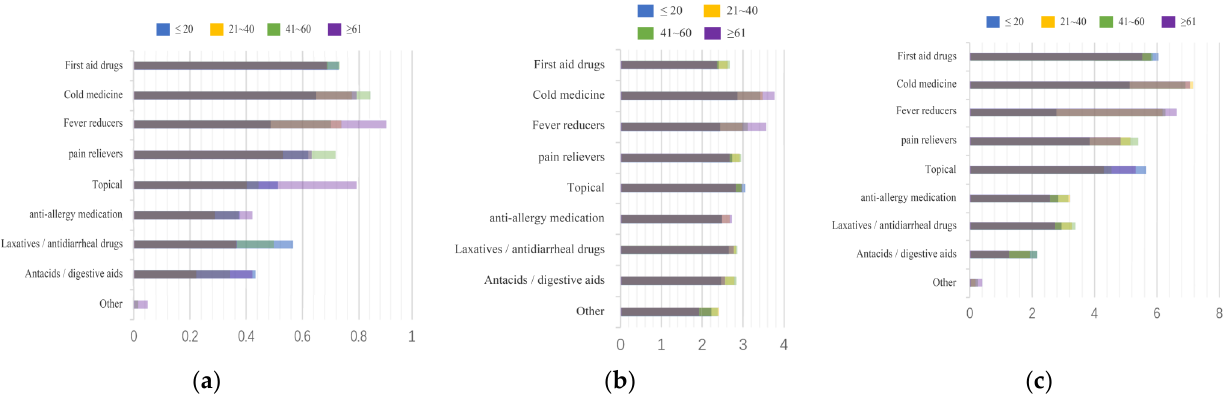
Figure 6. Summary of drug stockpiling, frequency of drug use, and ranking of drug importance by age. ( a ) Stockpile, ( b ) Frequency, ( c ) Rank.